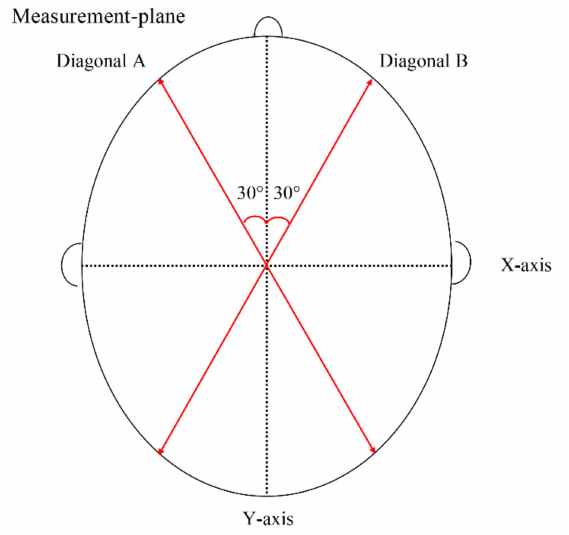
Figure 4. Measurement method for cranial asymmetry and cranial vault asymmetry index. CA (mm) = Diagonal A − Diagonal B. CVAI (%) = CA/Diagonal B × 100% (where diagonal A is greater than B). CA, cranial asymmetry; CVAI, cranial vault asymmetry